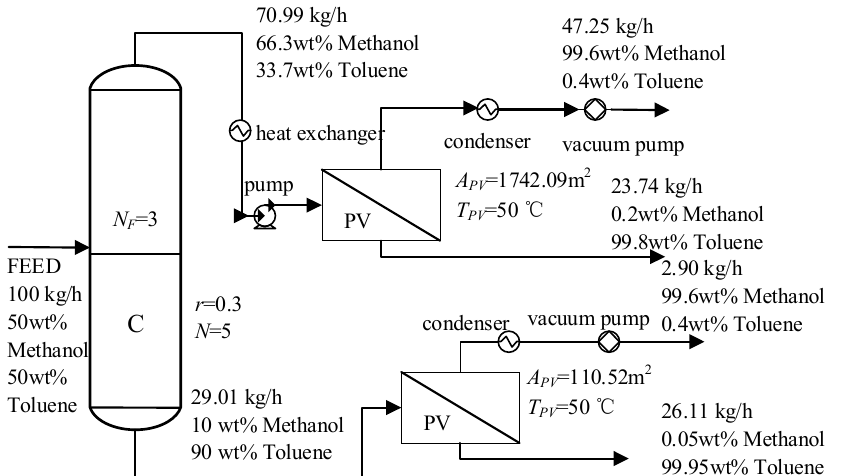
Figure 6. The optimal process structure and parameters of the chitosan membrane, when the feed flow rate is 100 kg/h and the methanol content is 50 wt%.